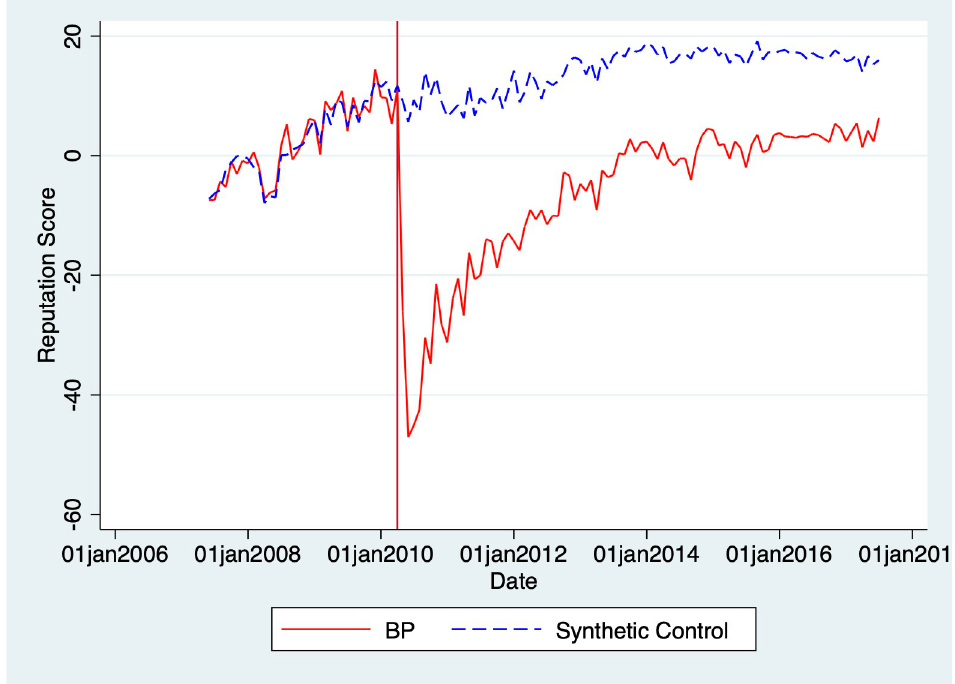
Fig 1. Reputation of BP vs. synthetic firm. Note: As Shell–which may itself have been impacted by the oil spill—is an important component of our synthetic control, we form a synthetic control excluding oil and gas firms as well.